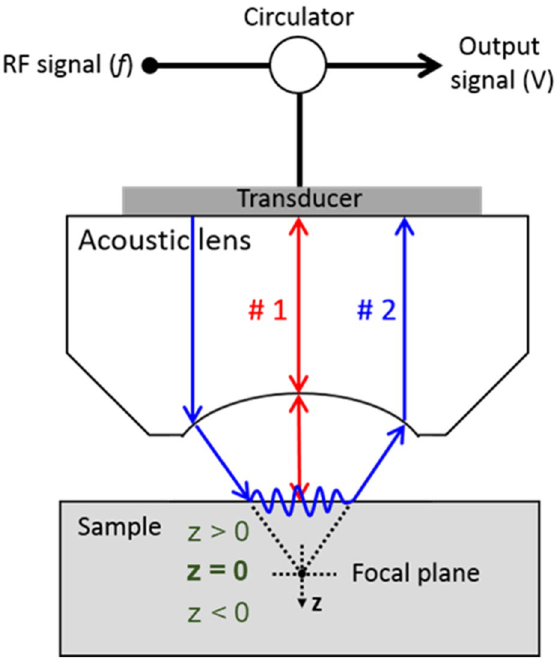
Figure 1. Schematic illustration of working principle of scanning acoustic